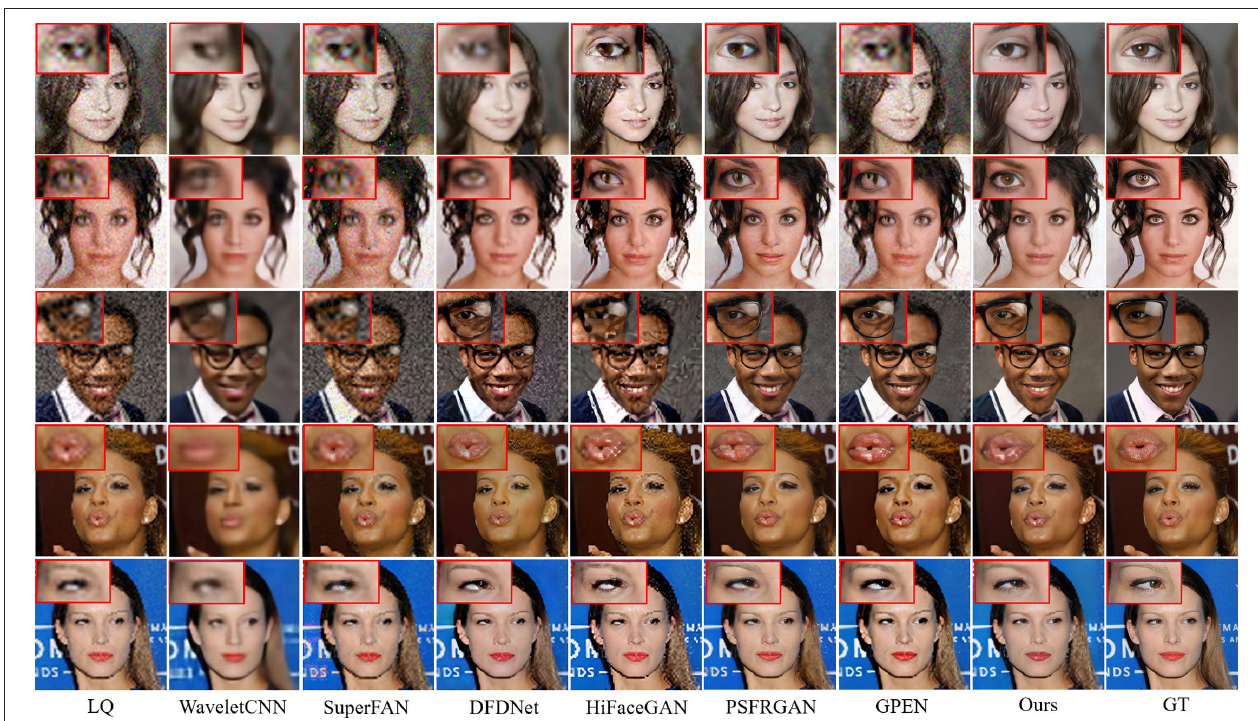
FIGURE 8 | Comparison of qualitative performance with state-of-the-art BFR methods from the literature.